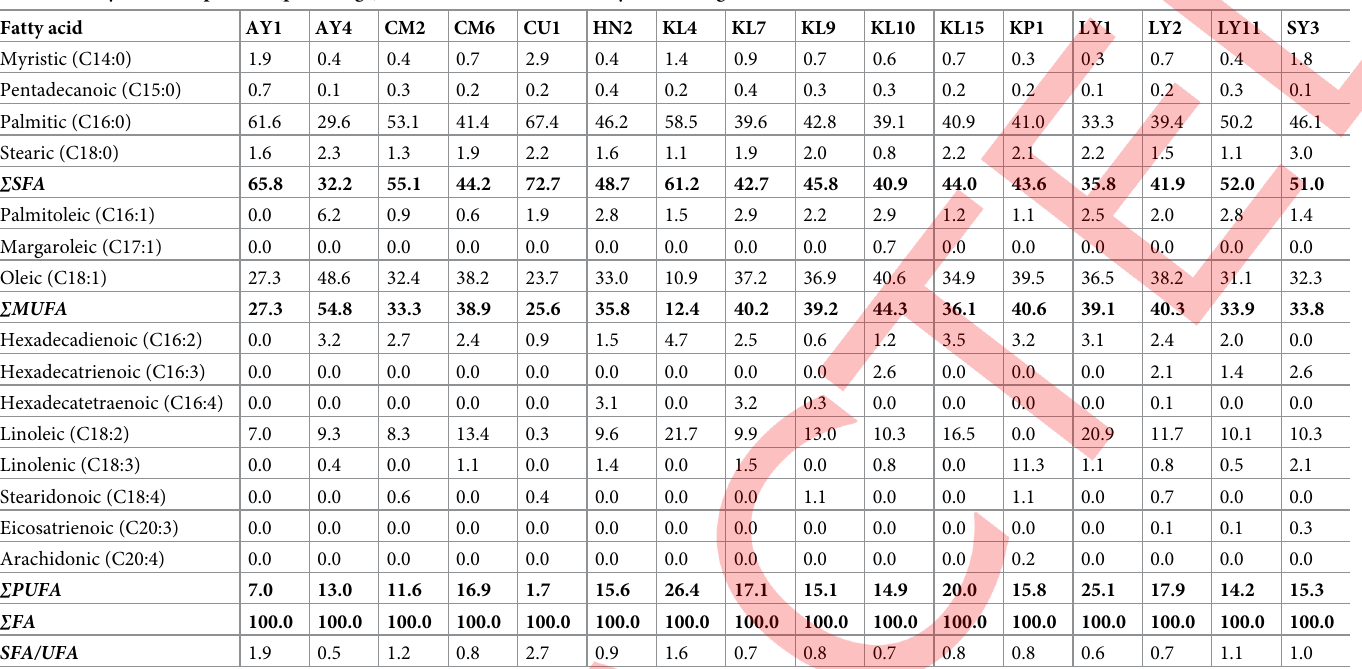
Table 2. Fatty acids composition (percentage) of the selected lower Himalayan